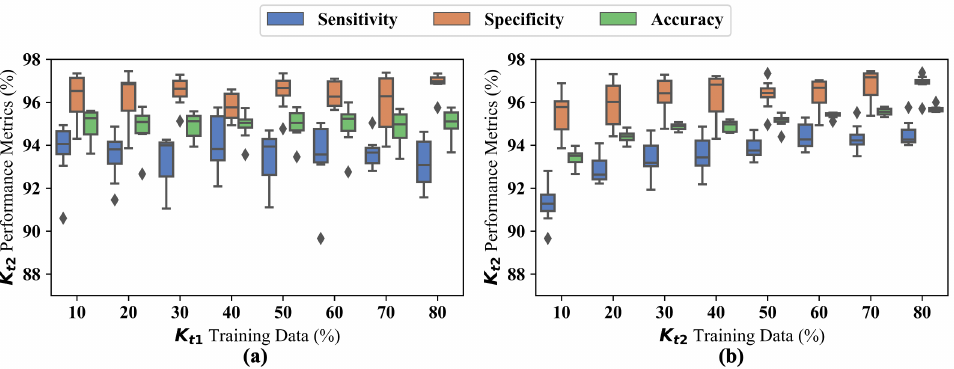
Figure 14. Distributions of the sensitivity, specificity, and accuracy of the K t 2 test data with variations in the training data percentages for ( a ) K t 1 and ( b ) K t 2 . The center lines on the boxplots represent the median, and the outliers are shown with